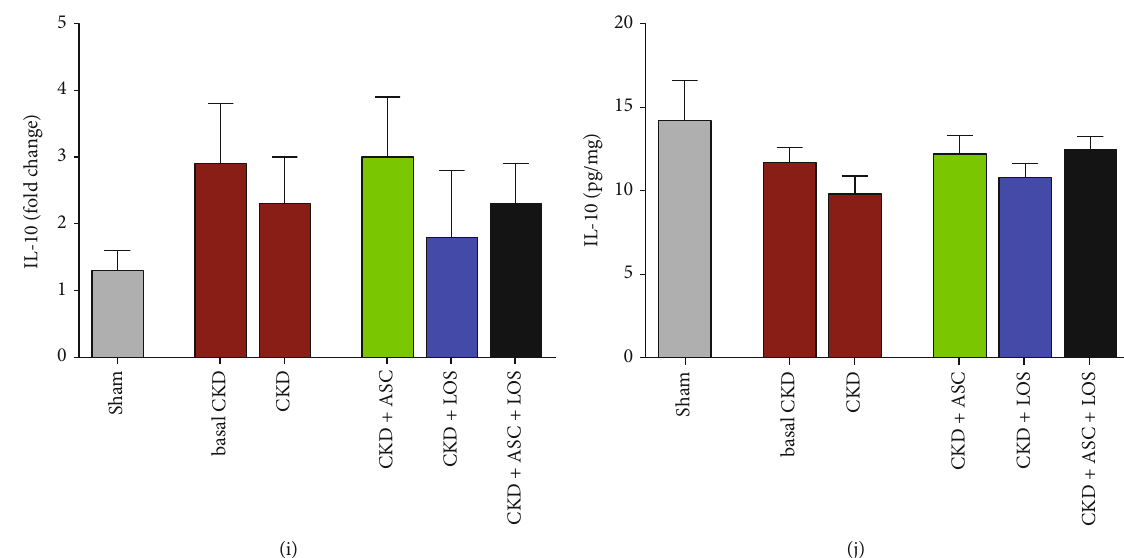
Figure 6: Bar graphs depicting the local renal gene and protein expressions of the following proin fl ammatory and anti-in fl ammatory mediators (a, b) IL-1 β , (c, d) IL-2, (e, f) IL-4, (g, h) IL-6, and (i, j) IL-10. Statistical di ff erences are ∗ p < 0 : 05 vs. Sham, § p < 0 : 05 vs. basal CKD, # p < 0 : 05 vs. CKD, † p < 0 : 05 vs. CKD+ASC, and ‡ p < 0 : 05 vs.